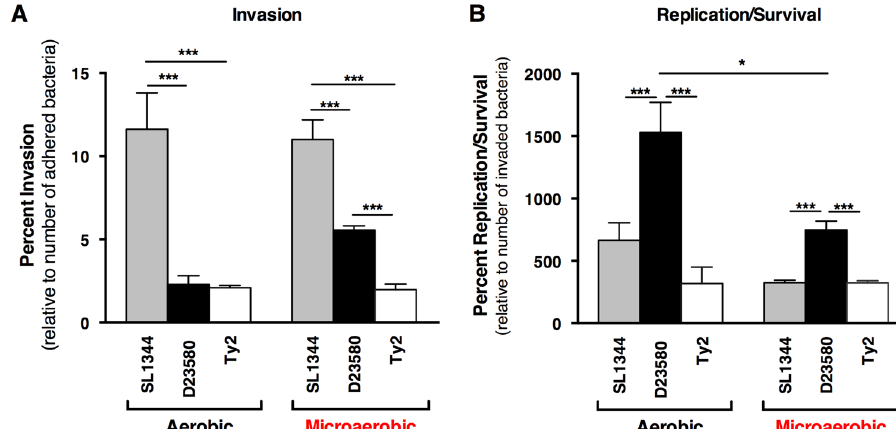
Fig. 5 D23580 displays enhanced intracellular survival relative to SL1344 and Ty2 following invasion in the 3-D co-culture model. A Percent invasion relative to number of adhered bacteria. B Percent replication/survival relative to number of invaded bacteria. Following invasion, D23580 ( black bars ) replicated/survived better than both SL1344 ( gray bars ) and Ty2 ( white bars ) (data normalized to the number of invaded bacteria). Bacteria were cultured under microaerobic or aerobic conditions. Statistically signi fi cant differences between strains are indicated as: (*) p < 0.05 or (***) p < 0.001. Error bars represent the standard deviation from two biological replicates, each conducted in technical